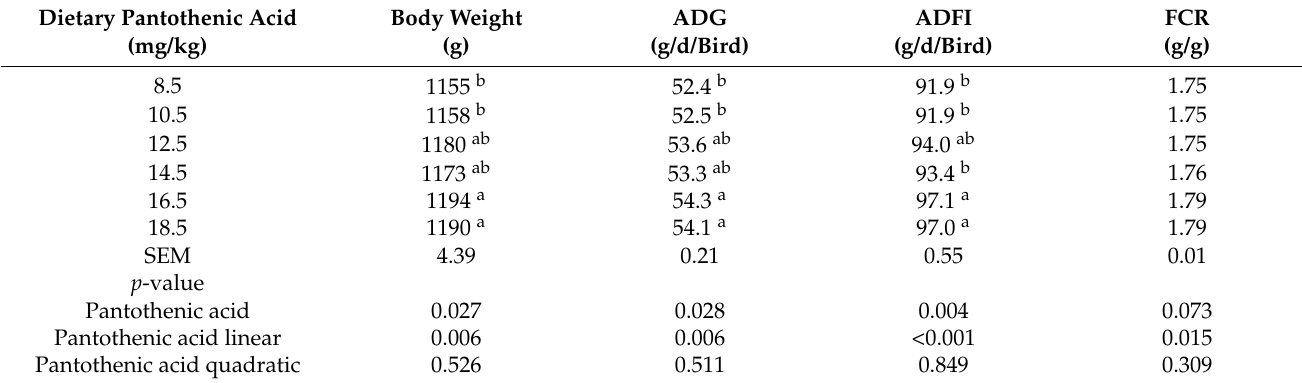
Table 3. Effect of dietary pantothenic acid levels on growth performance of male white Pekin ducks from hatch to 21 days of age 1 .